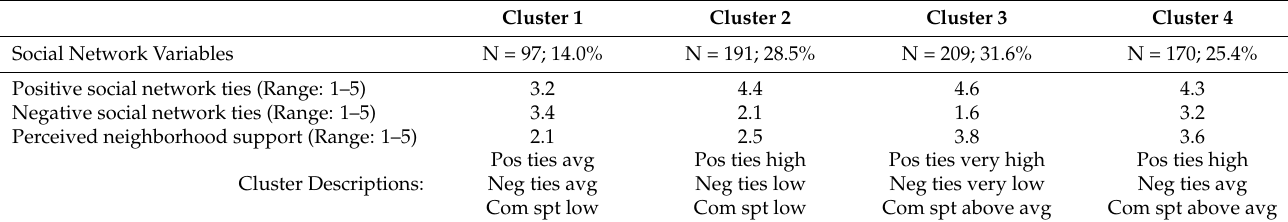
Table 2. Social Network Characteristics (N =